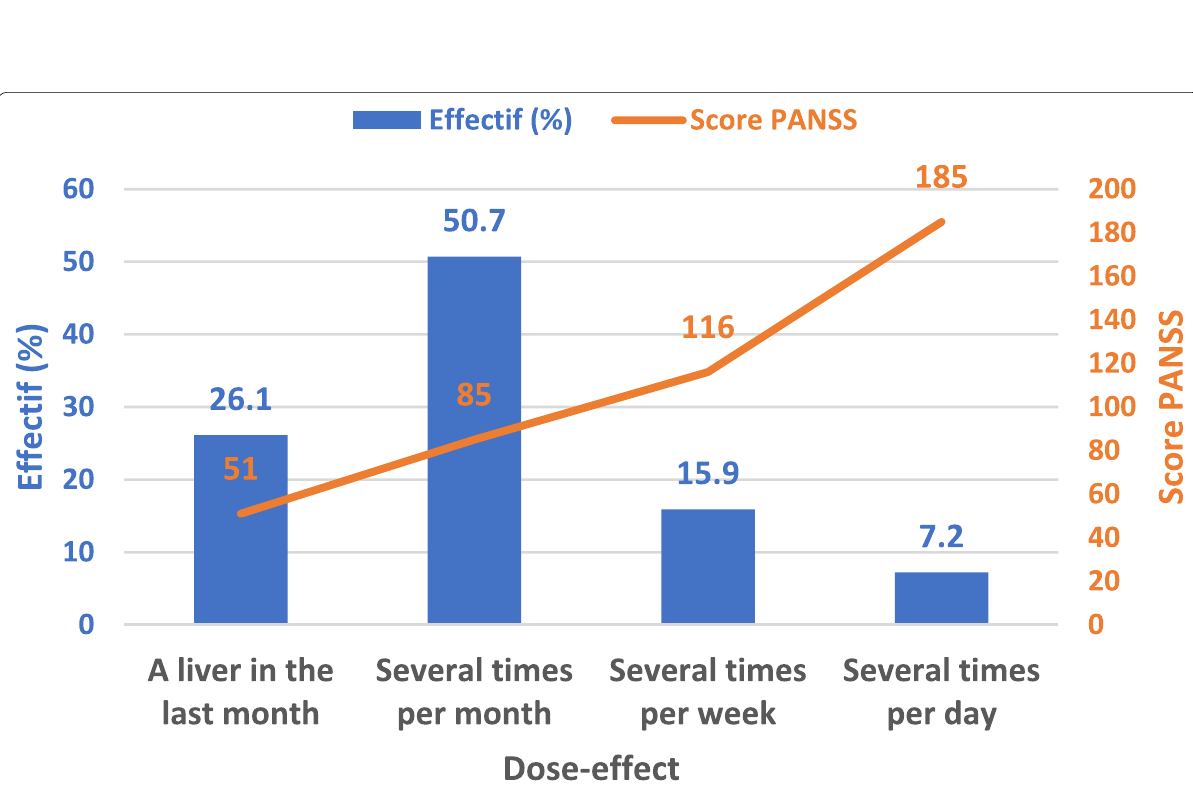
Fig. 2 Dose-effect relationship between cannabis dependence (CAST score) and PANSS total